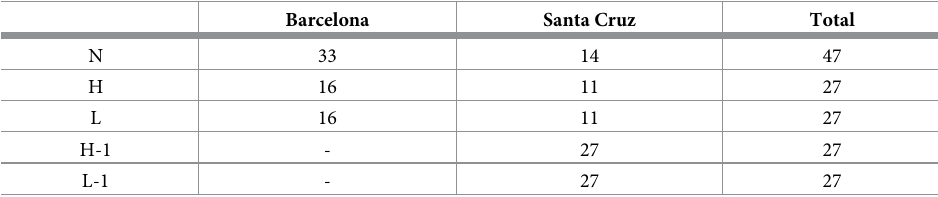
Number of arbiter observations per treatment and location along with the total across both